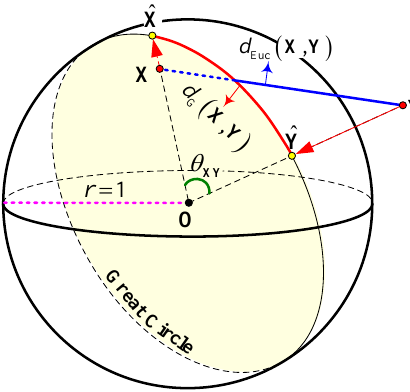
shortest distance between their projections ( ˆ X and ˆ Y ) on the unit sphere, as illustrated in Figure 3. This is also the reason why it is called geodesic distance in [72].